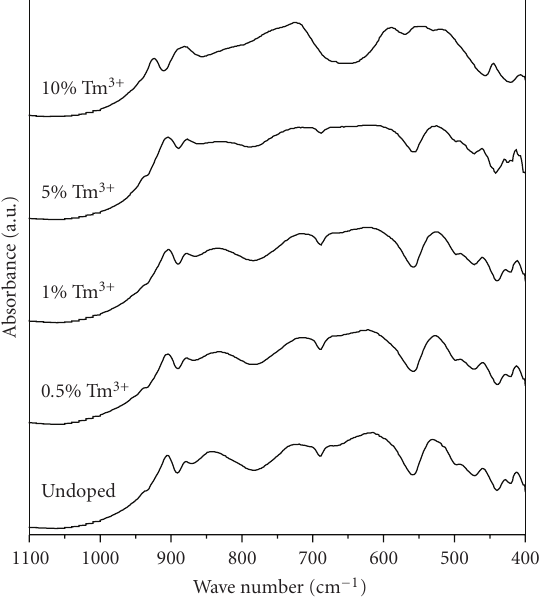
Figure 4: Room temperature FTIR spectra of LiIn 1 − x Tm x (WO 4 ) 2 ( x = 0, 0.5, 1, 5, and 10 at.%).